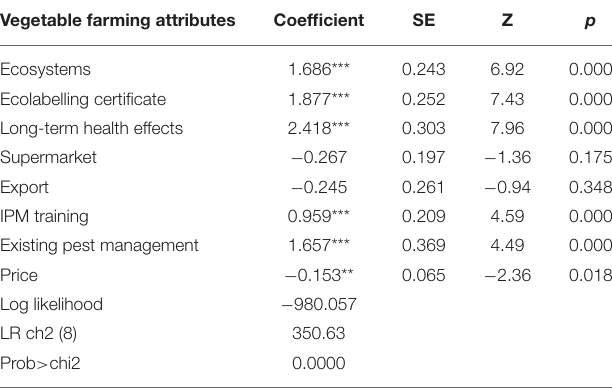
TABLE 4 | Results of the mixed logit model for environmentally friendly vegetable farming choice options. Vegetable farming attributes Ecosystems Ecolabelling certificate